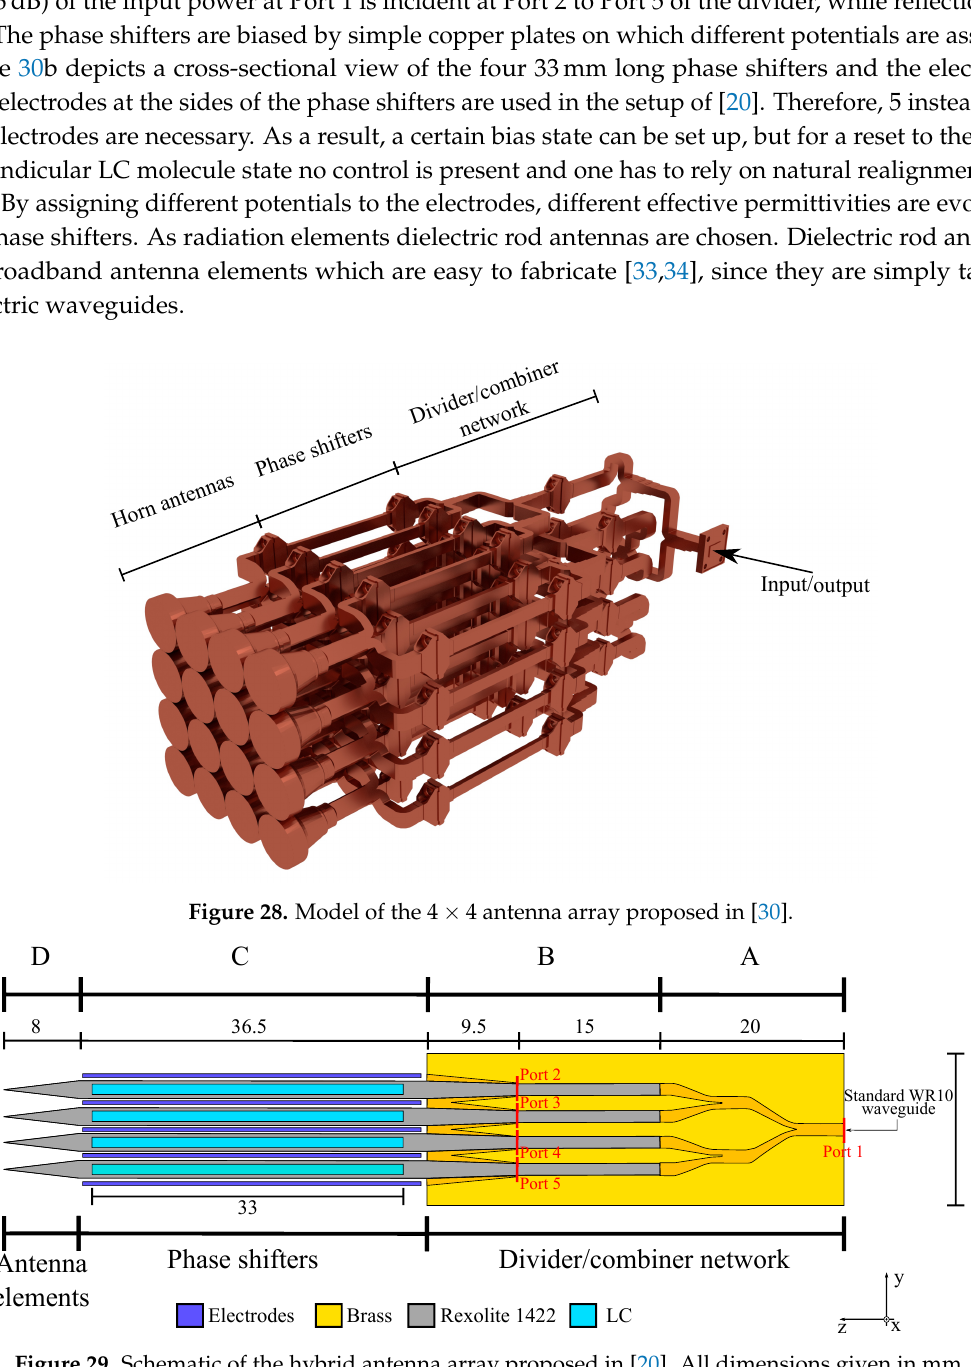
Figure 29. Schematic of the hybrid antenna array proposed in [20]. All dimensions given in